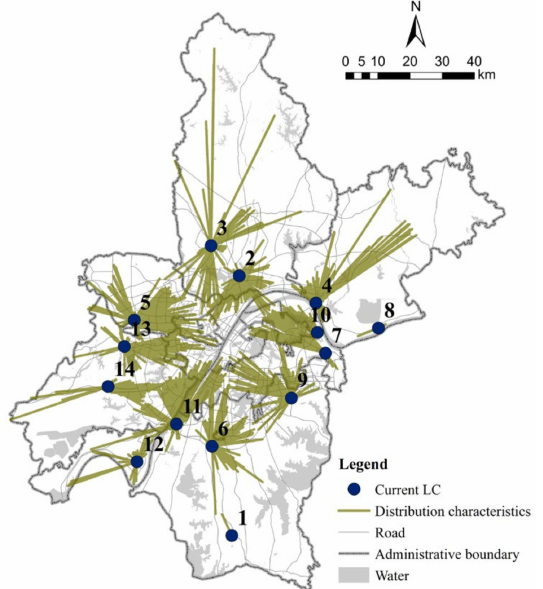
Figure 9. Site location and allocation results for current logistics centres by the P-median method.